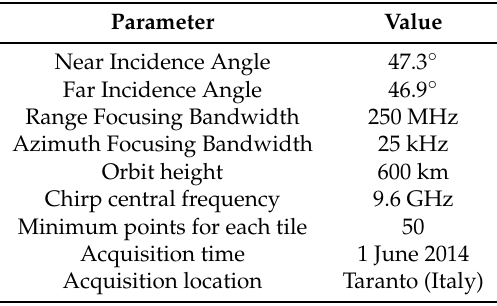
Table 2. SAR acquisition characteristics